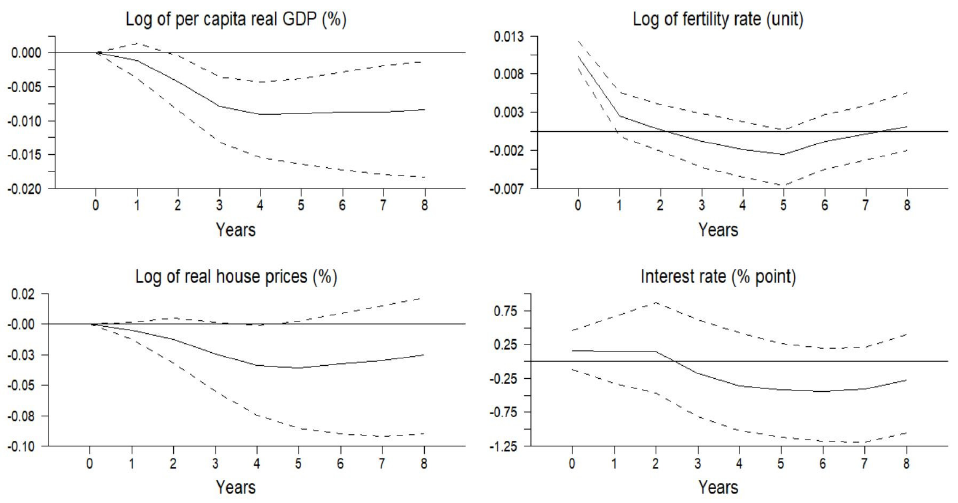
Figure 4. Responses to a fertility shock in the baseline SVAR.